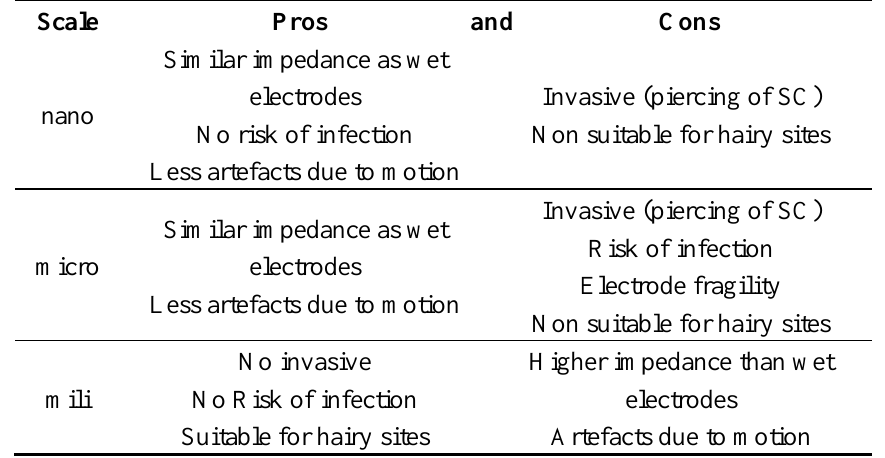
Table 1. Comparison of spike size, advantages and disadvantages of dry